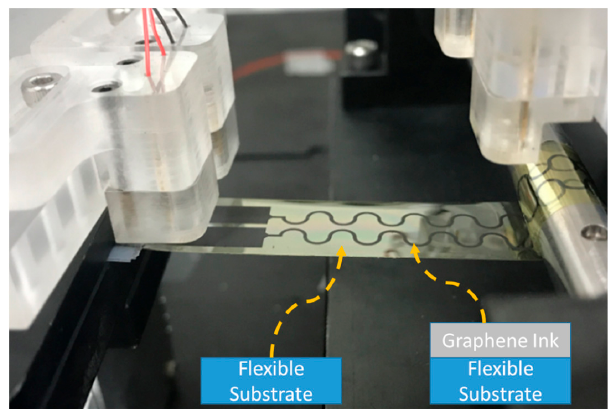
Figure 9. Testing condition and components of validated graphene ink sample.